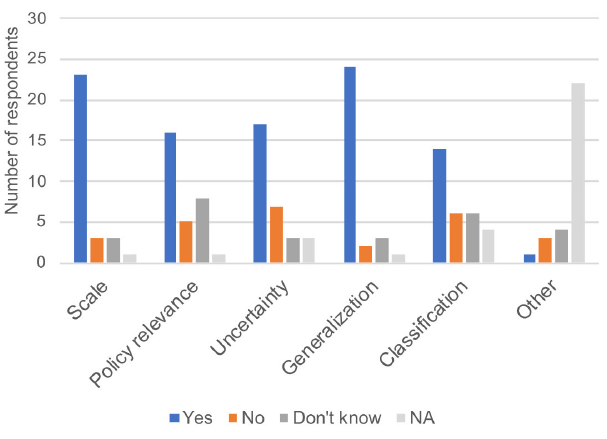
Fig. 2 . Perceived challenges related to the application of scenario